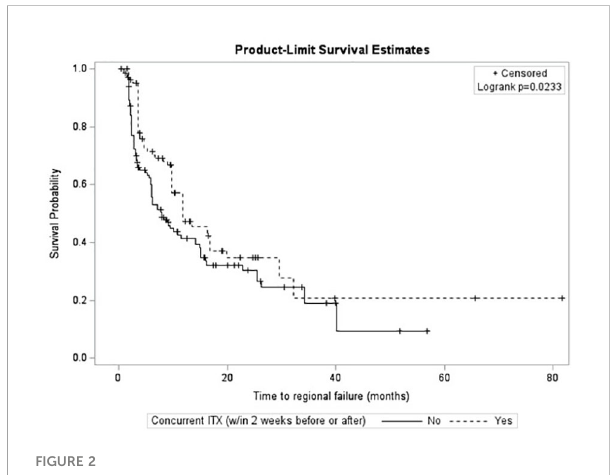
FIGURE 2 Kaplan-Meier curves for time to regional failure strati fi ed by